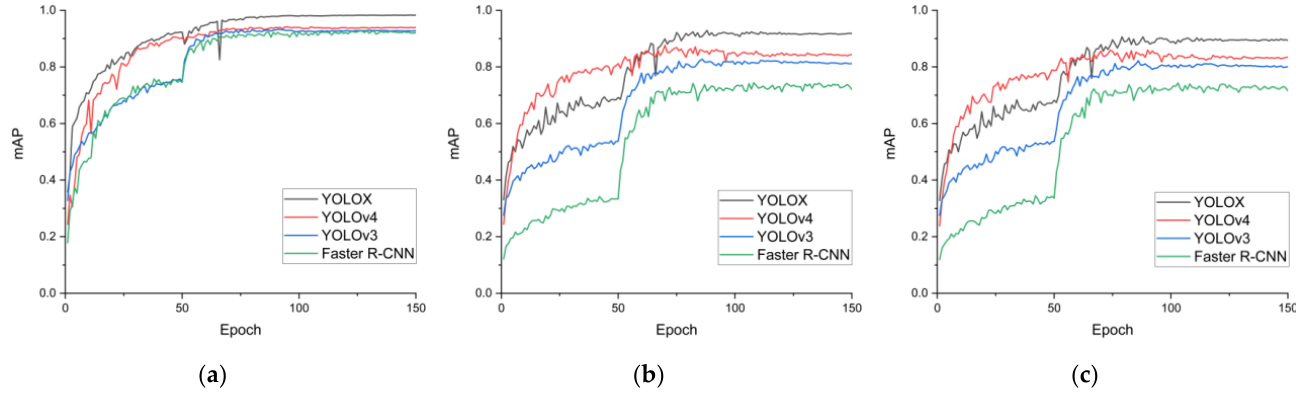
Figure 6. mAP curves of different models under different test datasets. ( a ) mAP curve of test dataset CPD, ( b ) mAP curve of test dataset HPD, ( c ) mAP curve of test dataset LPD.